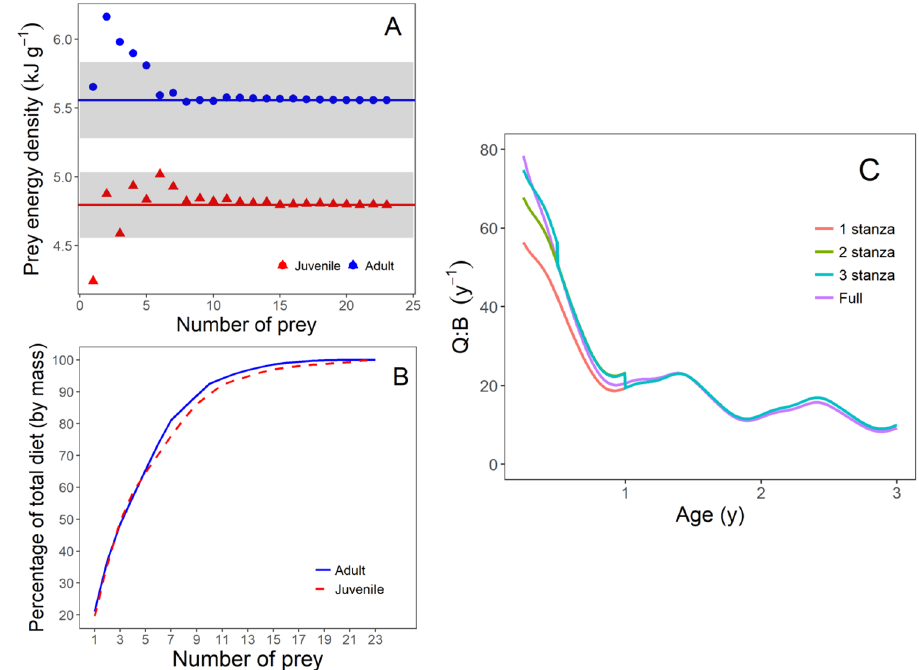
Figure 5. ( A ) The variation in mean prey energy density (kJ g − 1 ) against prey number. The weighted mean energy density for juveniles and adults was calculated with the most common prey items added sequentially. Red triangles show juveniles (0–1 y), blue circles show adults ( > 1 y). Horizontal lines represent the actual weighted mean for each stage (i.e. the weighted mean when all prey items are included). Grey bands show ± 5% from actual weighted mean for each stage. ( B ) The contribution (% by mass) of prey types to adult (full line) and juvenile (dashed line) tailor diet, illustrated as accumulation plots. C) The calculated relative consumption (Q:B, y − 1 ) as the number of prey stanzas is increased (1–3), compared to the full model. Each stanza represents the age class for which a constant prey energy density is calculated (from the 5 most common prey types per stanza). The lines of the 1, 2, and 3 stanza simulations > 1-year overlay. Compared with our full model, mean lifetime Q:B was underestimated by 11% using one stanza, 4% using two stanzas, and 1% using three stanzas. The x-axis is truncated at 0.25 and 3 years for